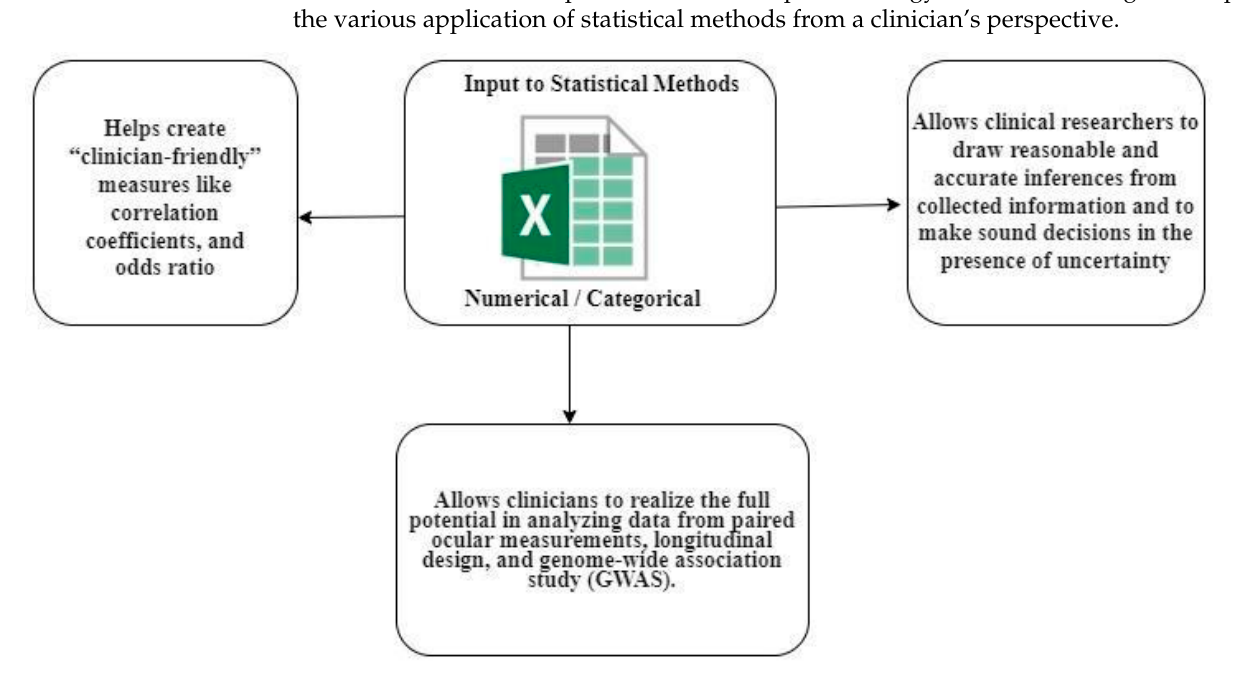
Figure 2. Year-wise classification of included articles.